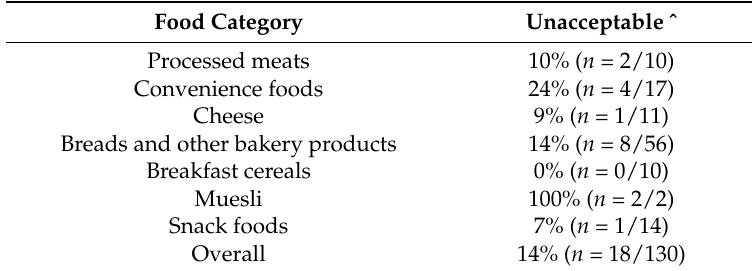
Table 3. Food label discrepancies between the analytical and label-declared sodium contents of processed foods analysed in